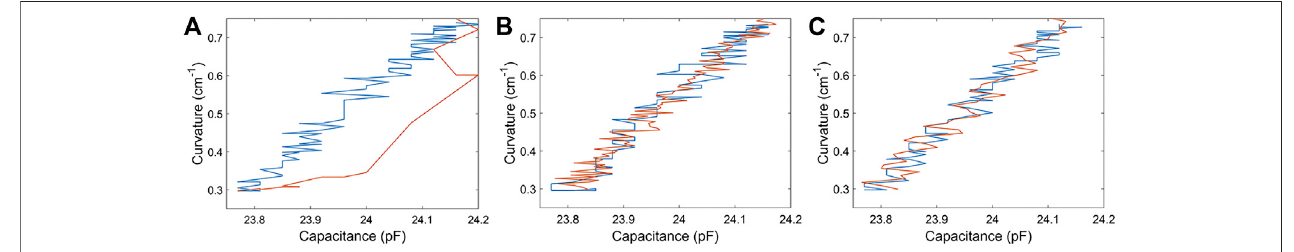
FIGURE 7 | Comparison of calibration result in different current situation. (A) Unlimited current actuation. (B) and (C) are under limited current actuation with constraint of 1.4 A and 2 A respectively. The orange line shows the relationship between measured capacitance and captured curvature in activation period while the blue line in relaxation period.